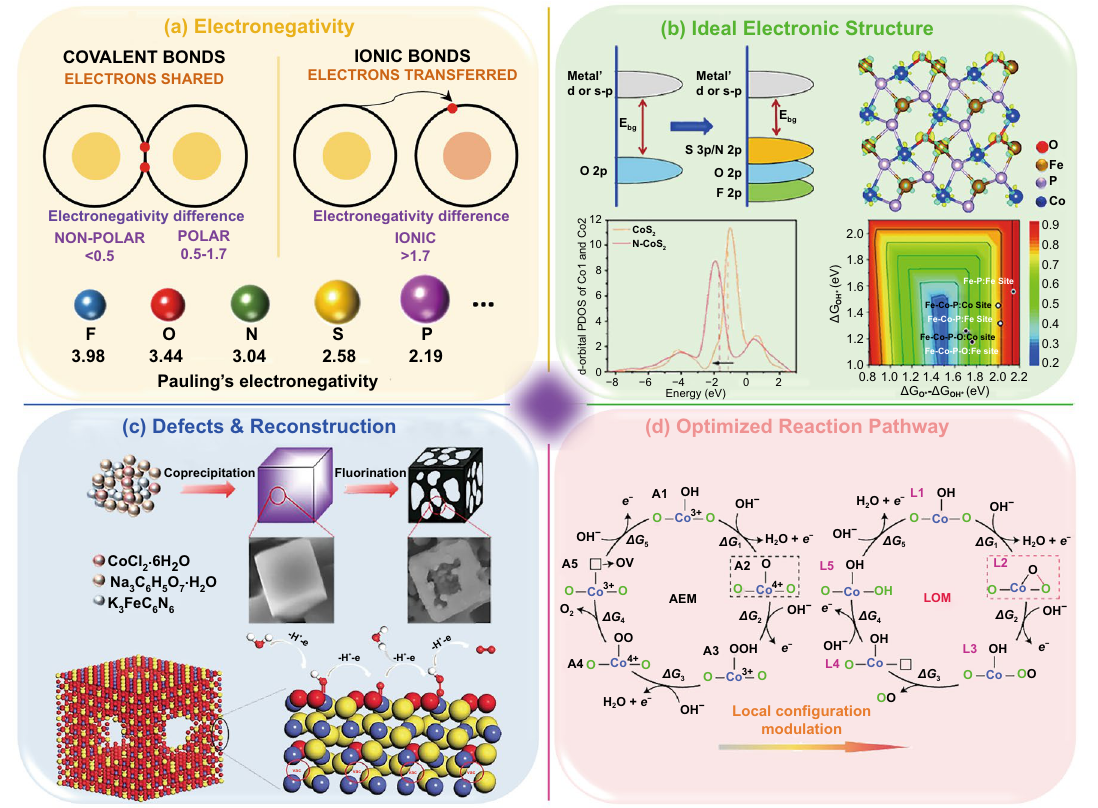
Fig. 2 Schematic illustration of the significant features of anion-mixed regulation involved in transition metal compounds for water-splitting. a Electronegativity. b Ideal electronic structure: Schematic illustration of the strategy for band gap narrowing through anion substitution (top left); The d -orbital partial density of states ( d -pdos) of Co in CoS 2 and N–CoS 2 (bottom left); Calculated redistribution of charge density for Fe–Co– P–O (top right, the yellow isosurface indicates electron accumulation, while the blue one represents electron depletion); Calculated volcano plot of OER overpotential η with ΔG OH* and ΔG O* – ΔG OH* as the descriptors (bottom right). Reprinted with permission from Ref. [44]. Copyright Year 2019, Wiley–VCH Verlag GmbH & Co. KGaA, Weinheim. Reprinted with permission from Ref. [45]. Copyright Year 2019, Wiley–VCH Verlag GmbH & Co. KGaA, Weinheim. Reprinted with permission from Ref. [46]. Copyright Year 2019, Royal Society of Chemistry. c Defects and reconstruction: Schematic illustration of the synthesis process of Fe–Co–F samples (top); Schematic illustration of the oxygen-containing amorphous cobalt sulfide porous nanocubes with Co–S dangling bands (bottom). Reprinted with permission from Ref. [47]. Copyright Year 2019, Elsevier. Reprinted with permission from Ref. [48]. Copyright Year 2017, Wiley–VCH Verlag GmbH & Co. KGaA, Weinheim. d Opti- mized reaction pathway: Proposed OER mechanisms of ZnCo–OOH, including AEM and LOM. A2 and L2 are the isomeric intermediates that differentiate between the OER pathways AEM and LOM. Reprinted with permission from Ref. [49]. Copyright Year 2019, Springer